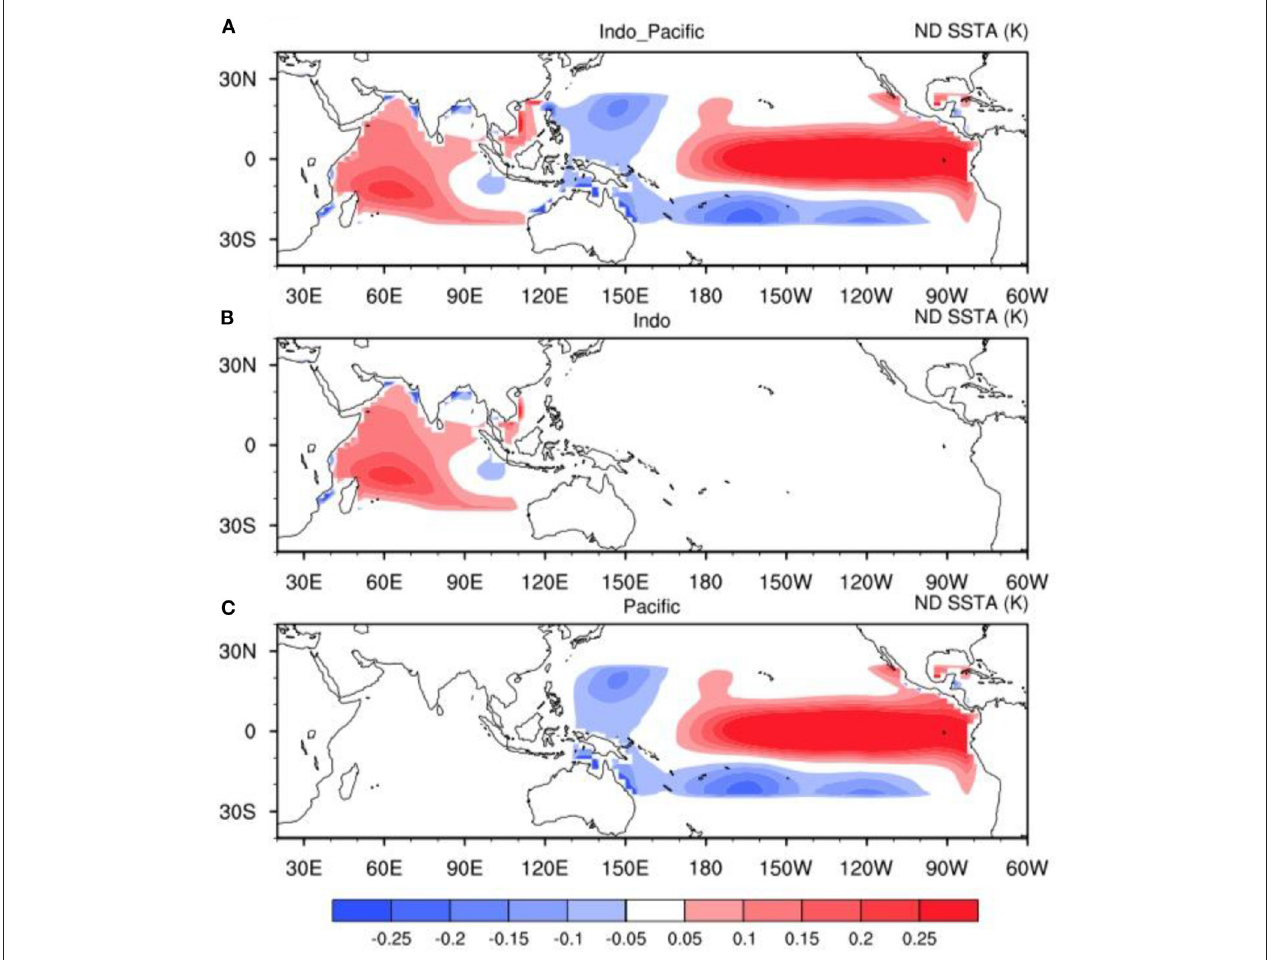
FIGURE 7 | The SST anomalous forcing scheme in model experiments. (A) SST forcing added in both western Indian ocean and tropical Pacific ocean, (B) SST forcing added only in the western Indian ocean, (C) SST forcing added only in the tropical Pacific